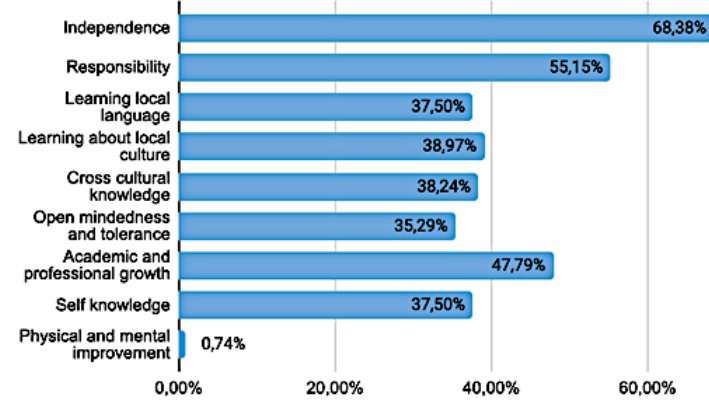
Figure 3: Outcomes of academic stays for international students in Barcelona REGION : Volume 9, Number 2,